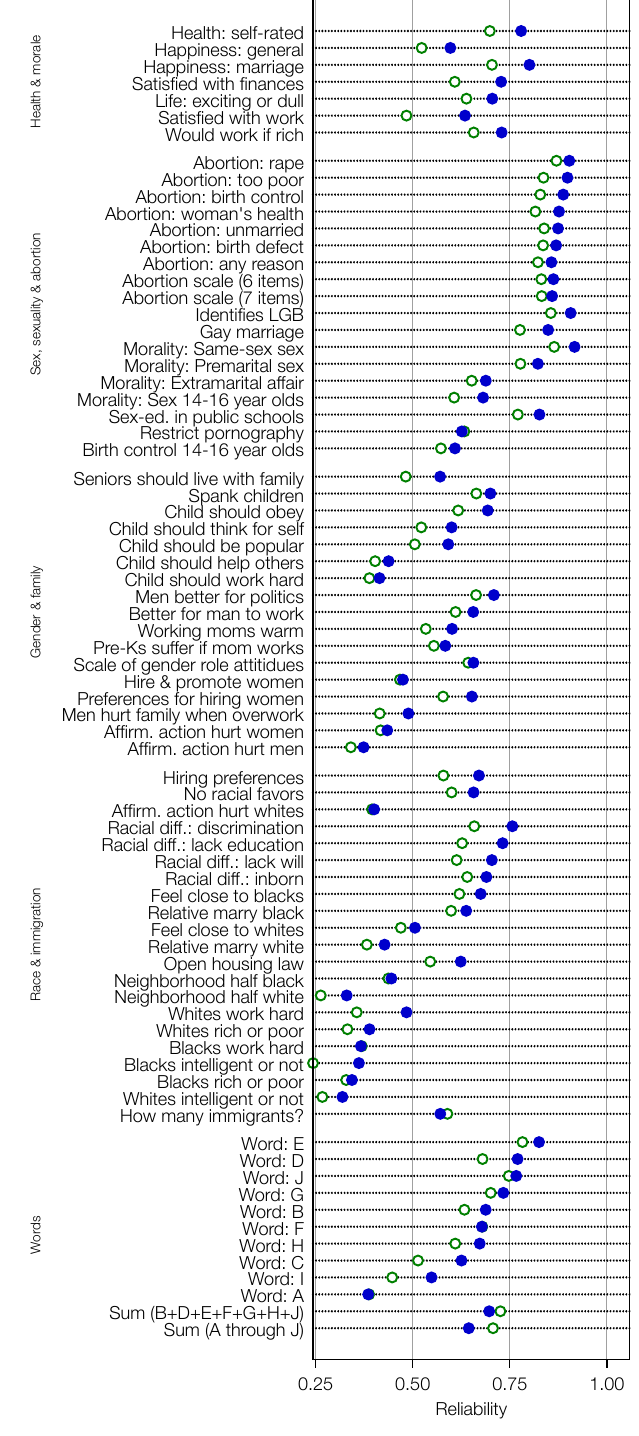
Figure 8: Reliability estimates for items about sex, gender, race, and vocabulary. Key: The estimates from the Alwin–Heise model are shown by solid blue circles; the estimates from our hierarchical linear models are in open green circles. The open green circle is not visible when the estimates are very close. Source: Authors’ calculations from the General Social Survey three-wave panels, 2006–2014. sociological science | www.sociologicalscience.com